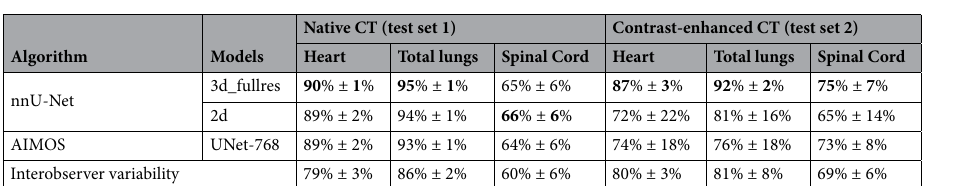
Table 3. Performance of the models against the reference contour in terms of the generalized conformity index ( CI gen ) (mean ± SD) for the native and contrast-enhanced CT datasets. The model with the best results are shown in bold.